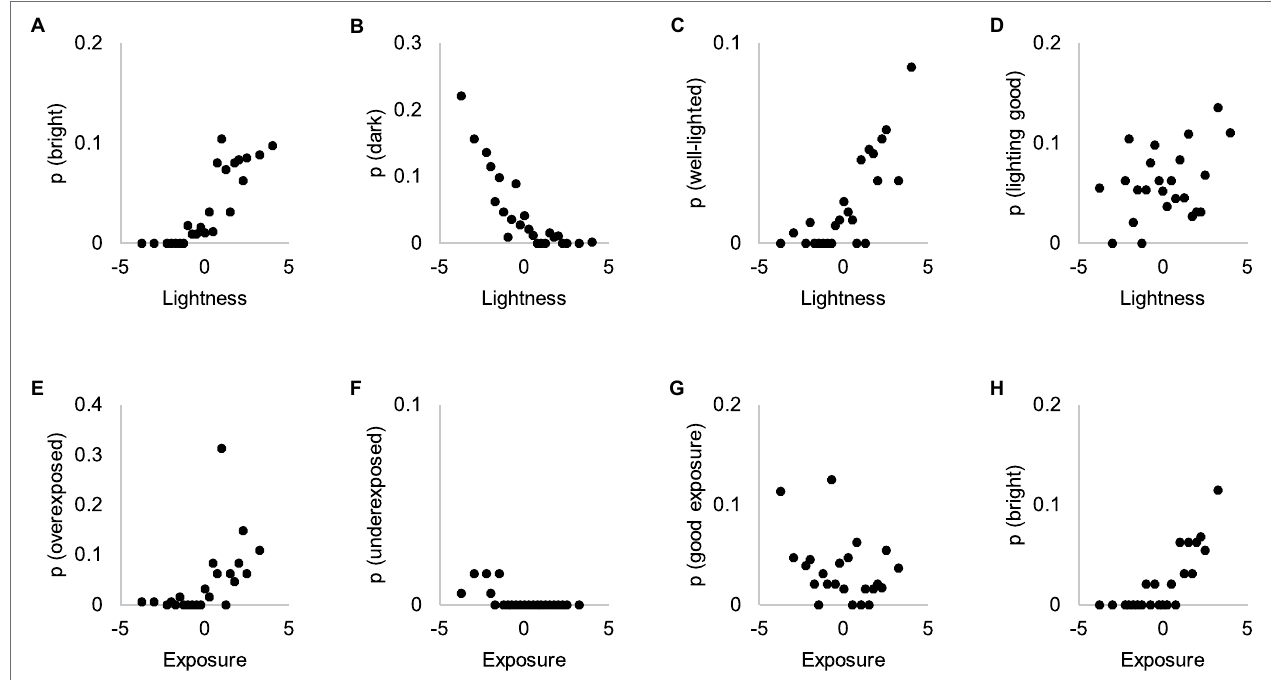
FIGURE 10 | Attributes referring to brightness (A,H) , darkness (B) , lightness (C) , quality of lightness (D) , overexposure (E) , underexposure (F) and quality of exposure (G) in Experiments 1 and 2. The y -axis shows the probability of an attribute in Experiment 1 explanations and the x -axis the visibility of the attribute in Experiment